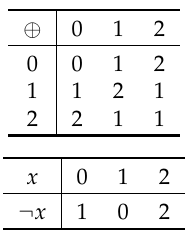
Table 4. Operations tables for the independence of ( MV 4 ) .